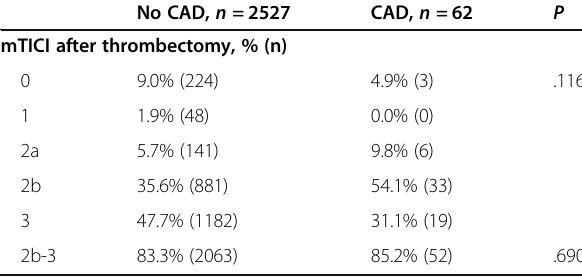
Table 3 Reperfusion